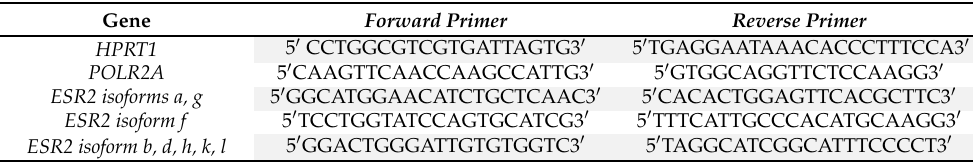
Figure 4. Expression of ESR2 isoforms in endometrial cancer and adjacent control endometrium. ( A ) ESR2 isoforms a, g; ( B ) ESR2 isoforms b, d, h, k, and l; and ( C ) isoform f. Expression in 34 paired EC samples is shown. Table 1. Primers for amplification of ESR2 isoforms and reference